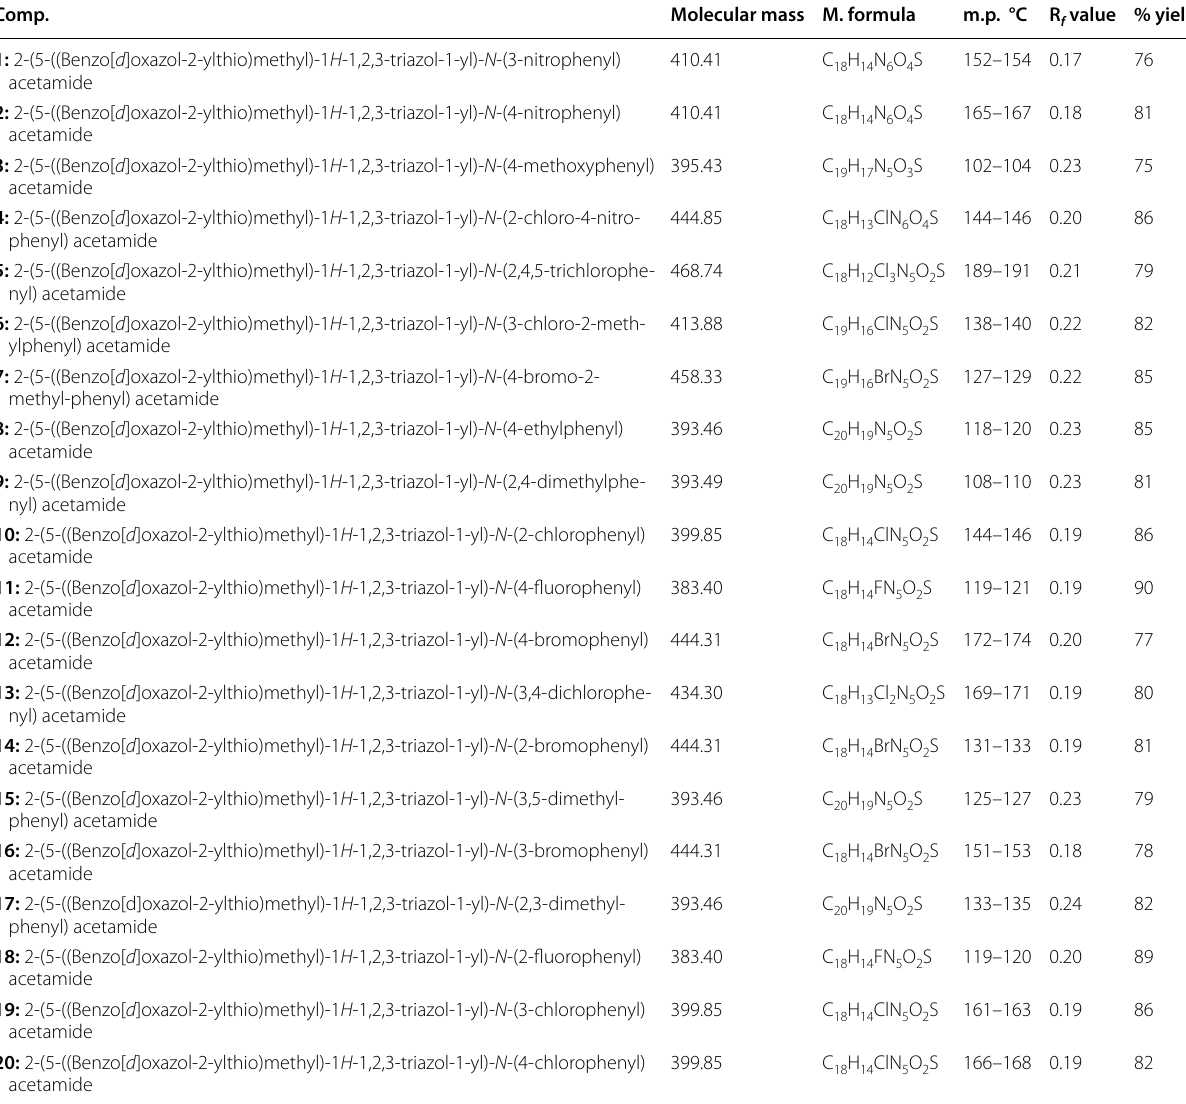
Table 1 Physicochemical properties of synthesized benzoxazole derivatives